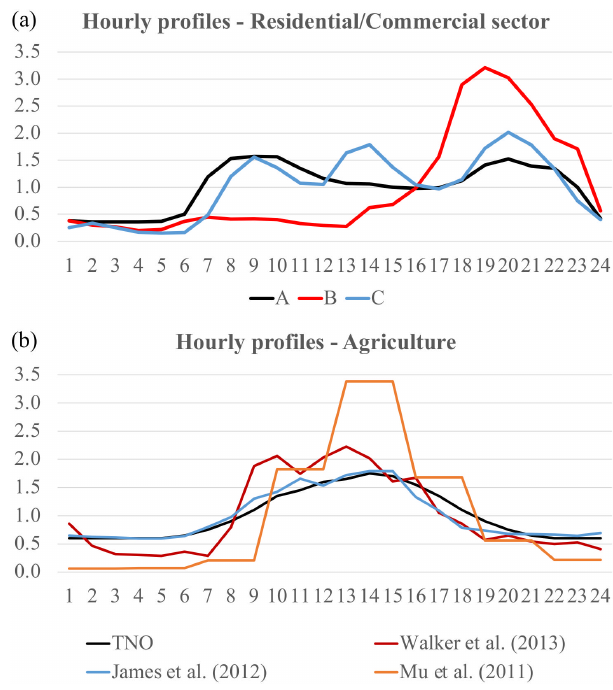
Figure 2. (a) Proposed hourly temporal profiles for the residential and commercial combustion sector where profile A refers to NO x, SO x and CH 4 emissions in urban and rural areas of developed and developing countries; profile B refers to PM 10 , PM 2 . 5 , CO, CO 2 , NMVOC and NH 3 in urban and rural areas of developed countries; and profile C refers to all pollutants in rural areas of developing countries. (b) Comparison between the hourly temporal profile pro- posed by TNO for agricultural emissions (Denier van der Gon et al., 2011) and the three measurement-based temporal profiles re- ported by Walker et al. (2013) derived from NH 3 flux measurements performed in a fertilized corn canopy in North Carolina, James et al. (2012) based on direct NH 3 measurements performed in a me- chanically ventilated swine barn and Mu et al. (2011) derived from active fire satellite